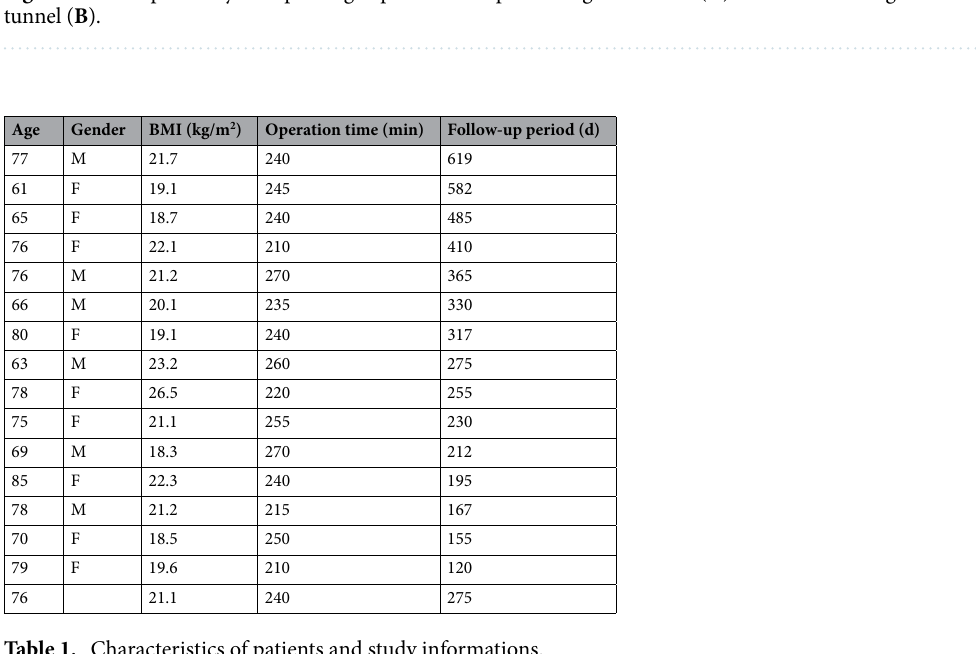
Figure 4. The tip of Kelly forceps has grasped the stump of the sigmoid colon ( A ) and drawn through the tunnel ( B ).